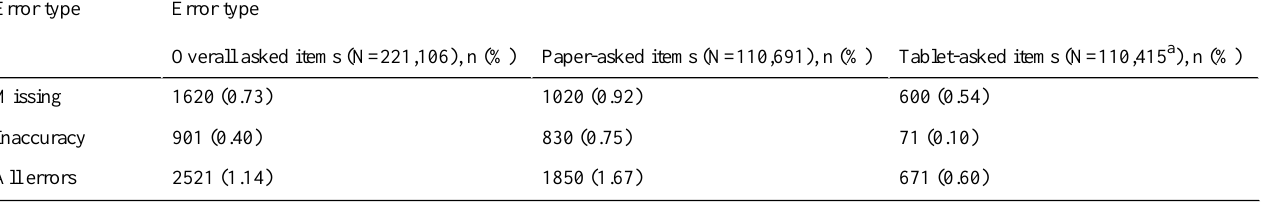
Table 1. Error rate by types of errors and the tools used during a survey in a demographic survey site in 2016, in Dabat, northwest Ethiopia.